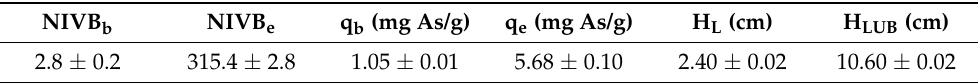
Figure 7. Breakthrough curve for arsenic adsorption using a 13 cm-high column packed with ChM hydrogel beads. Arsenate solution was fed at a rate of 8.5 mL/h, having an initial pH of 7.0 and an initial concentration of 5 mg As(V)/L. Table 5. Results obtained from the As adsorption at an initial pH of 7.0 using a 13 cm-tall column packed with ChM hydrogel beads. C 0 = 5 mg/L. Flow rate = 8.5